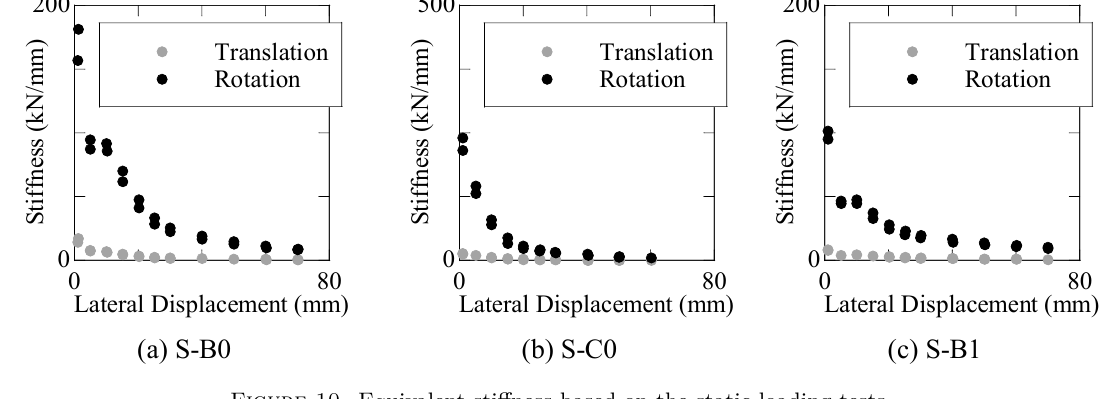
Figure 10. Equivalent sti ff ness based on the static loading tests.